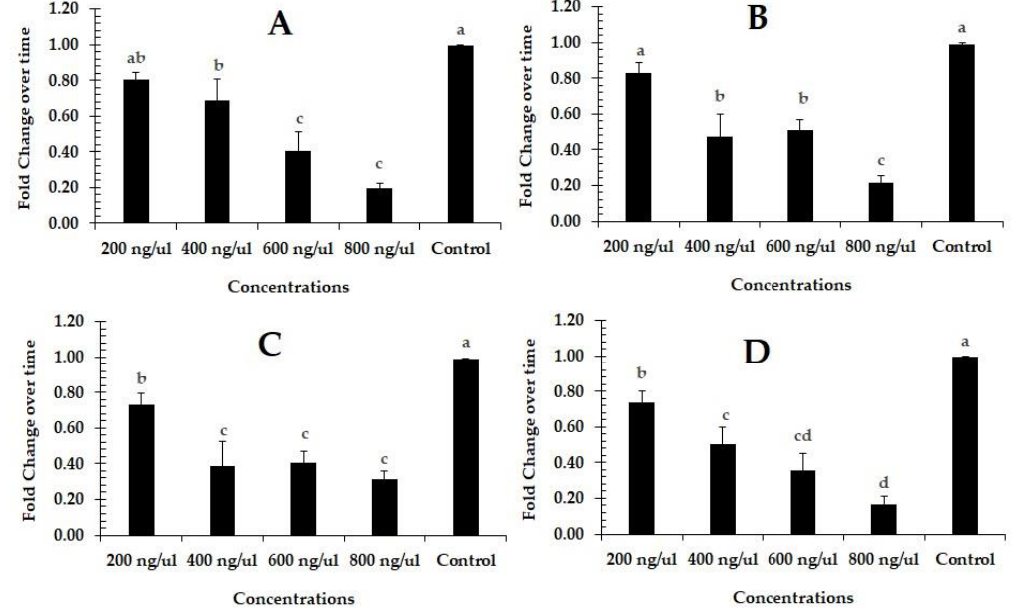
Figure 2. The effect of RNAi-mediated efficacy and silencing of target genes in different developmental stages of citrus red mites: ( A ) larvae; ( B ) protonymphs; ( C ) deutonymphs; and ( D ) adults at different concentrations (200, 400, 600, and 800 ng/µL) of dsRNA- PcCHS1 using the leaf dip method. The normalized gene expression is shown in comparison to the dsRNA- egfp control (set to 1- fold). The treatment bars show the mean value of three independent replications ( n = 50 per replicate), while error bars show the mean deviation. Different lower-case letter(s) above the bars indicate significant differences in the relative expression of the target gene (Fisher’s LSD test, α < 0.05). Different small case letters on the bars showing significant difference between the treatments.